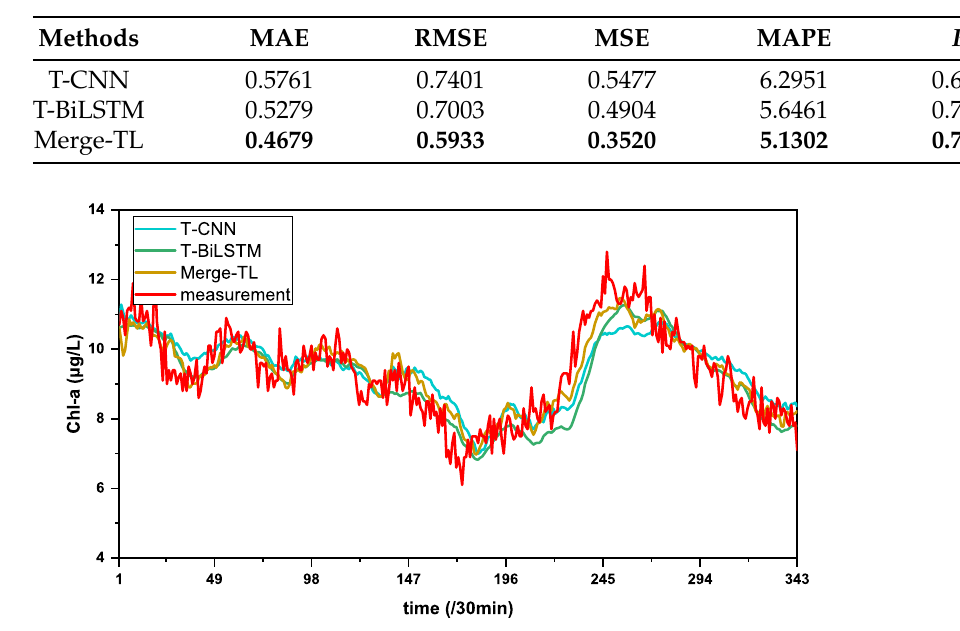
Figure 8. Results of the 3 h prediction for each model at site S7, where the total number of the prediction data points is 343, and the corresponding time period is from 20:30 on 23 September to 23:30 on 30